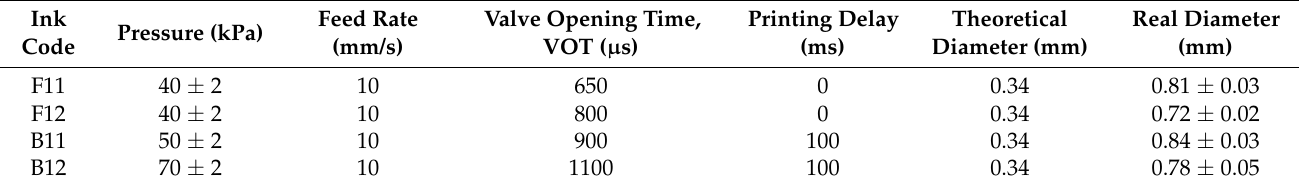
Figure 2. ( A ) Photographs of line-printing tests performed by varying the temperature from 25 to 40 °C. ( B ) Measurements of printed line widths vs. temperature. ( C ) Representative 3D printed constructs with F11 (*), F12 (**), B11 (#), B12 (##) designed as disc (10% honeycomb pattern infill) ( a ), square (10% grid-shape infill) ( b ) and hollow triangle ( c ) with dimensions of 10 mm in 4, 10, and 20 layers, respectively. Table 2. Printing parameters for CNF/GelMA biomaterial ink formulations.